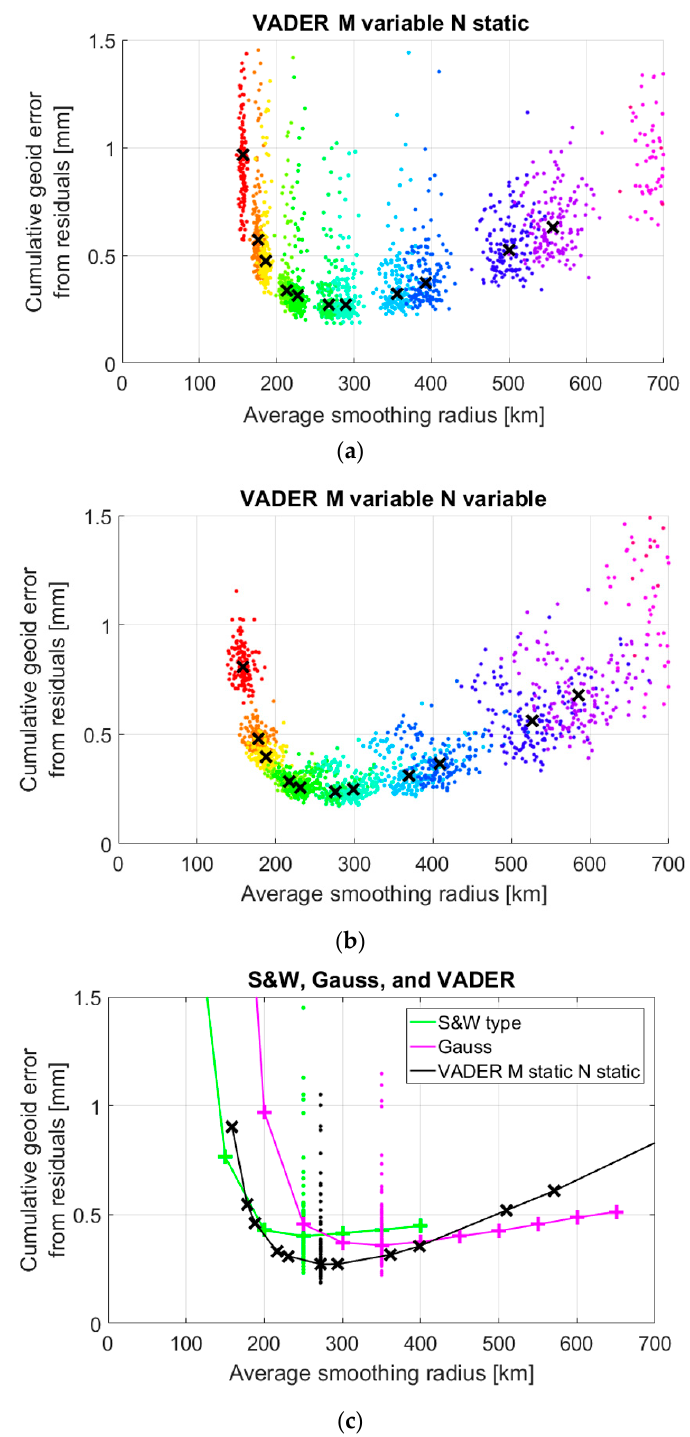
Figure 4. Cumulative geoid error from residuals for different static and non-stationary states of the error covariance matrix and signal variance matrix fed into the design of the VADER filter. Colors indicate the respective result for specific filter strength for the individual months of a 143 month time series. Black x-marks indicate the median cumulative geoid error at the median average smoothing radius of the respective cluster of results. ( a ) Stationary error covariance and cyclo-stationary signal variance. ( b ) Non-stationary error covariance and cyclo-stationary signal variance. ( c ) Stationary error covariance and stationary signal variance. In addition for comparison 143 individual monthly results for the Gaussian and empirical decorrelation